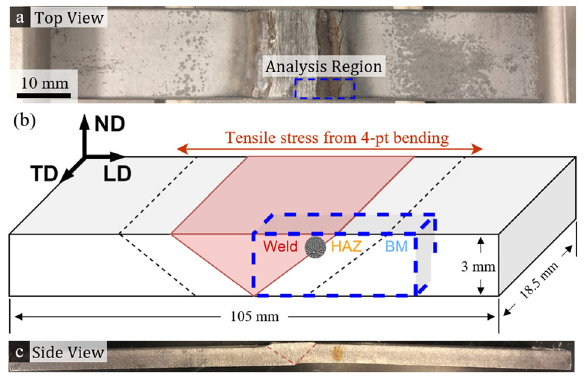
Fig. 10 Welded coupon after stress corrosion crack testing in boiling magnesium chloride solution. a , c Top view and side view; b schematic illustration of the welded sample dimension, three different zones produced by GTA welding, and fi nal EBSD analysis regions, marked by Kikuchi pattern (images are adapted from ref. 43 ). Table 2. Summary of FEA simulation results, organized by subgroup of crack-grain boundary interactions corresponding to encircled data points in Fig.